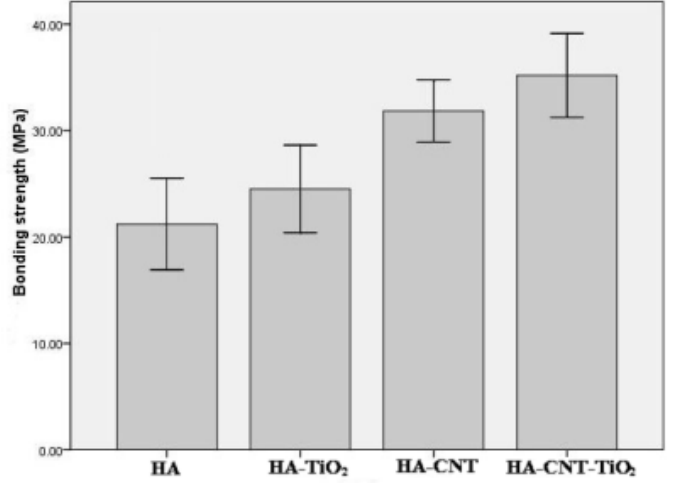
Figure 6. Bonding strengths of different coatings deposited on Ti substrates.